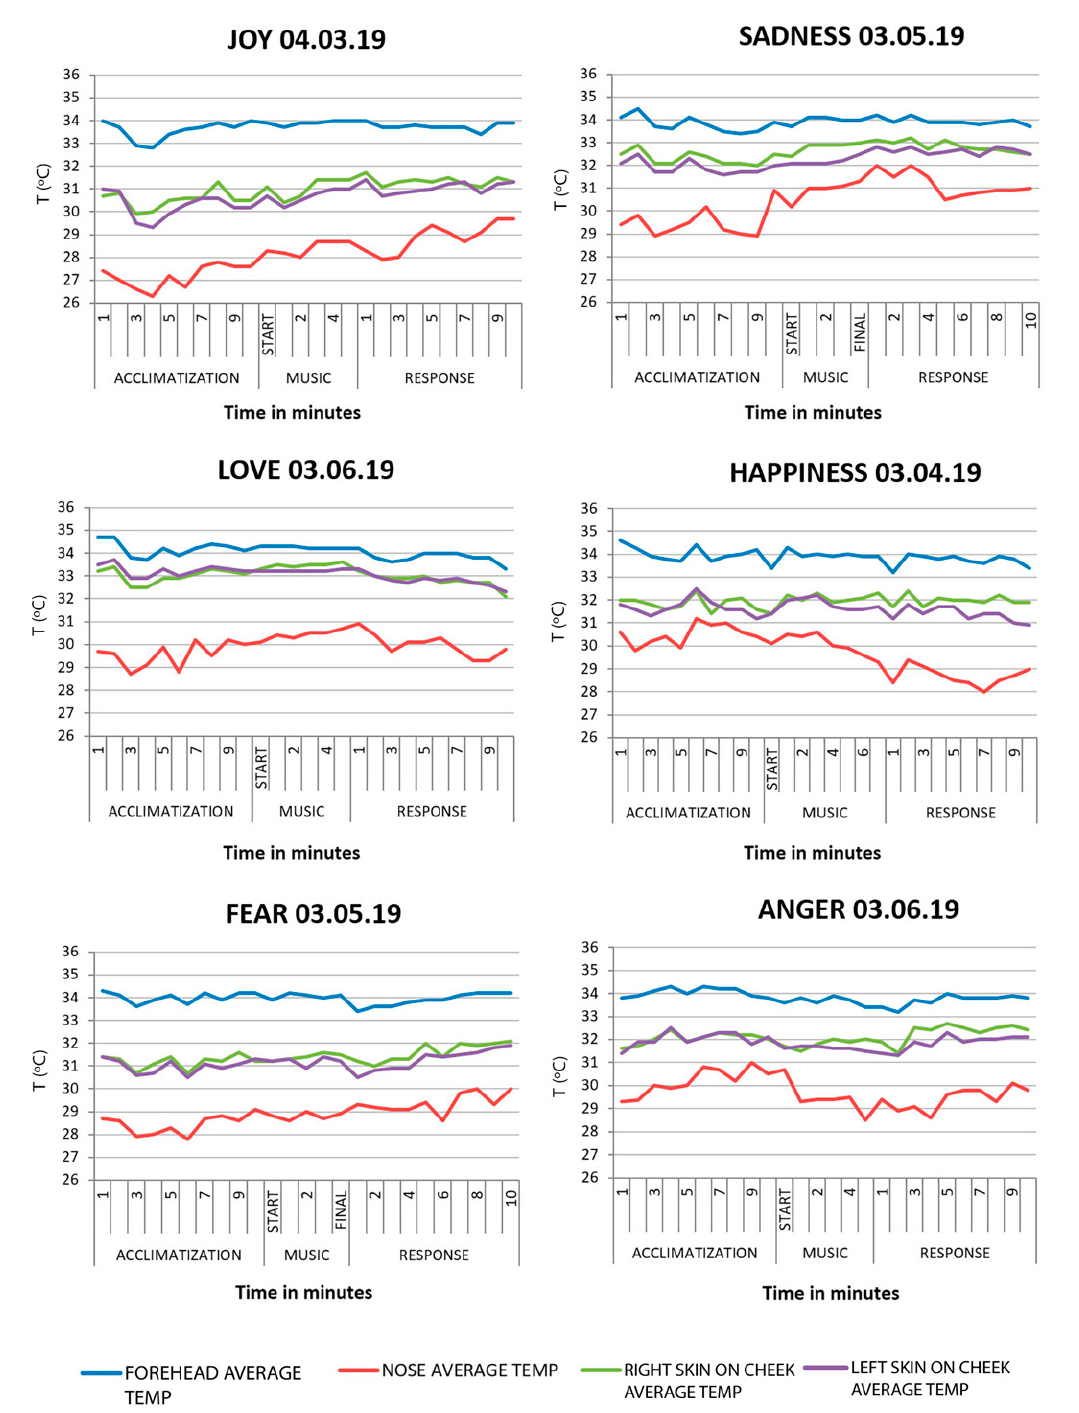
Figure 6. Lineal graphs showing the variation of the average temperature by facial areas during part B of the study.